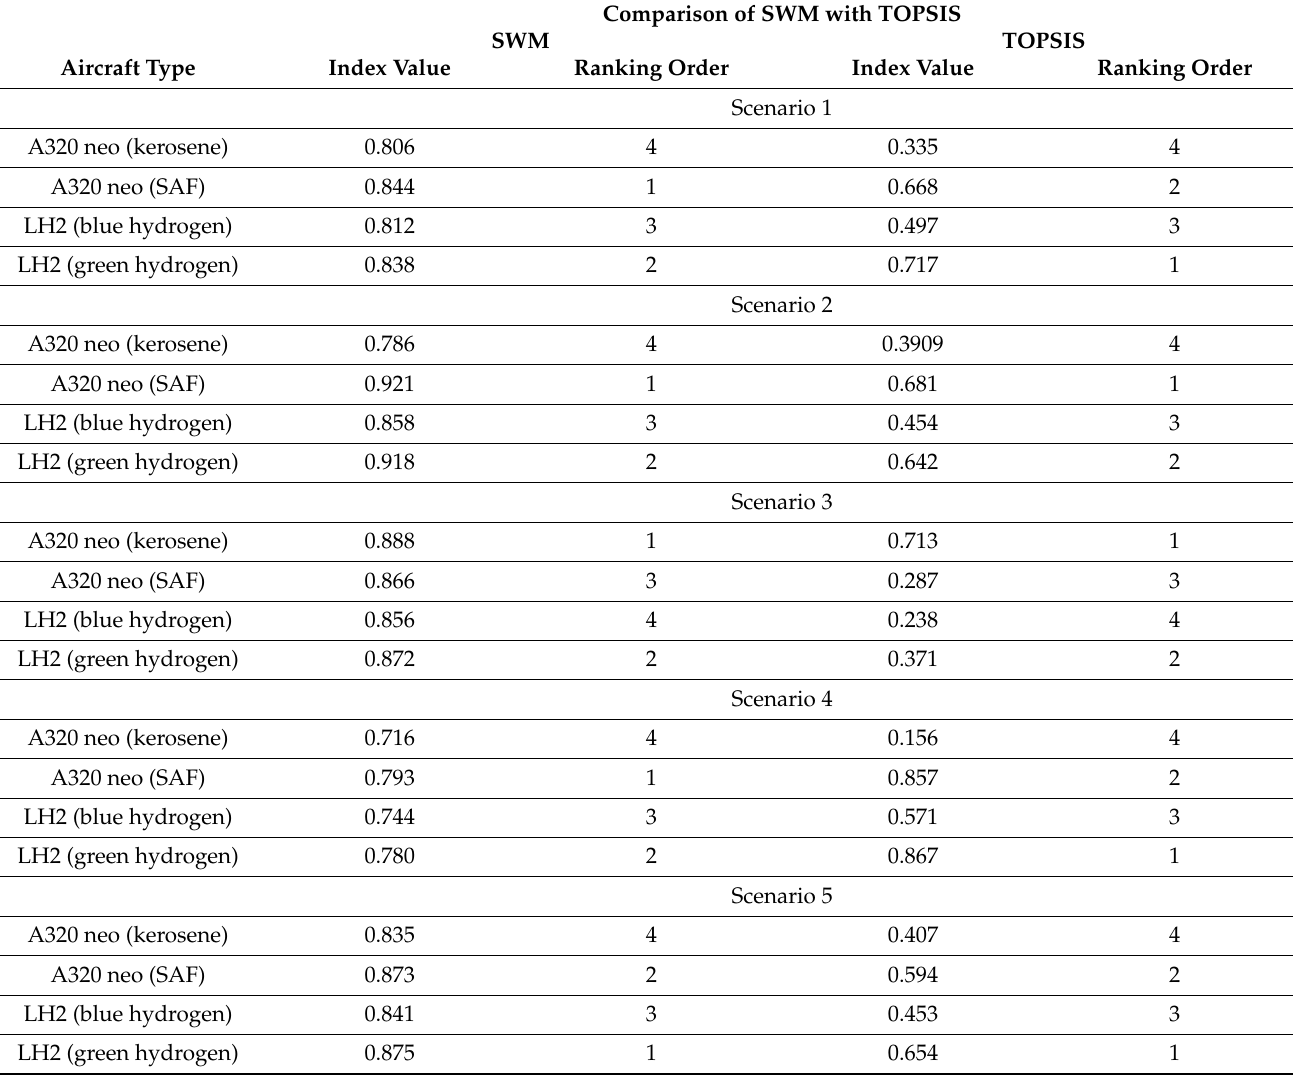
Table 4. Comparison of AHP-WSM with